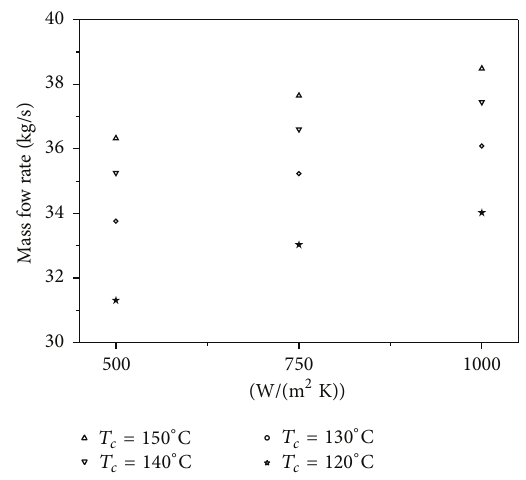
Figure 6: Mass flow rate in two-phase quasisteady stage under different